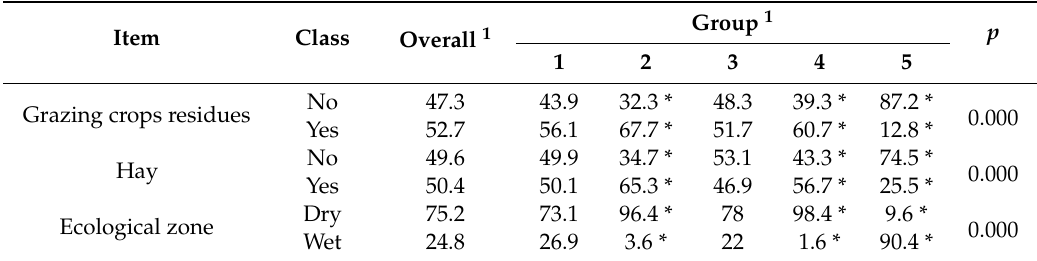
Characterization qualitative variables according to groups obtained for smallholder dual-purpose farms.